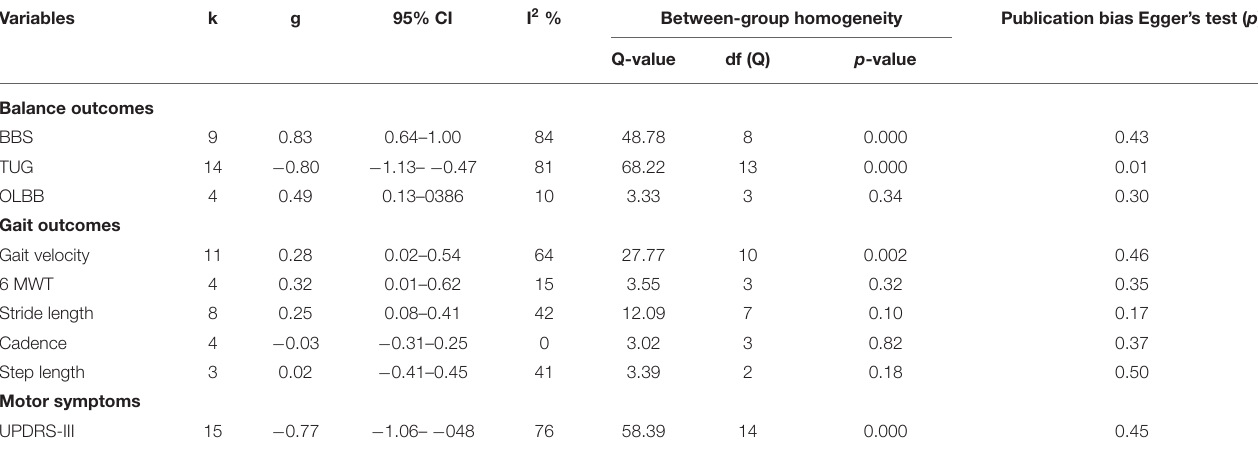
TABLE 3 | Synthesized results for the effects of TCE vs. control group